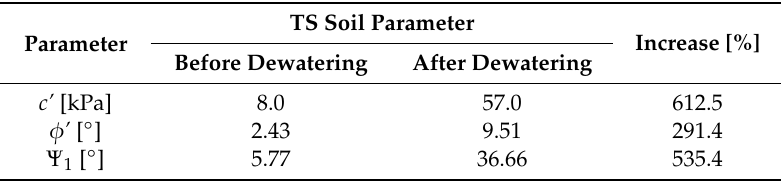
Table 2. The e ff ect of increases in parameters caused by electrokinetic